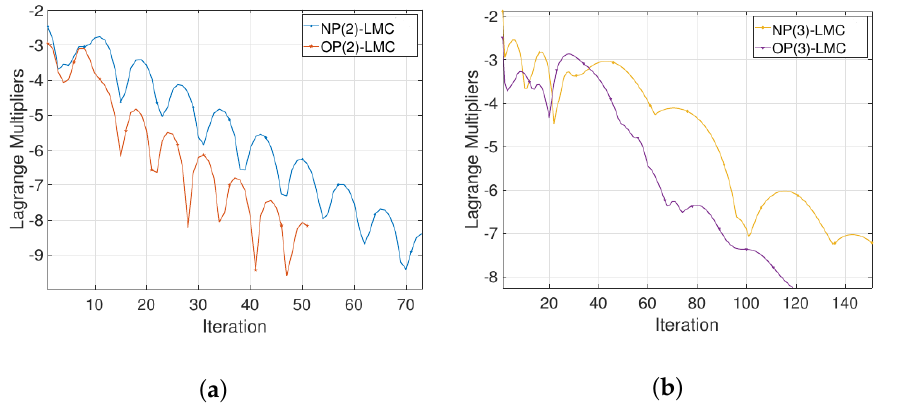
Figure 4. Convergence of Lagrangian multiplier with different partitions. ( a ) Two regions, iterative performance; ( b ) Three regions, iterative performance. (NP(2)-LMC and NP(3)-LMC are from